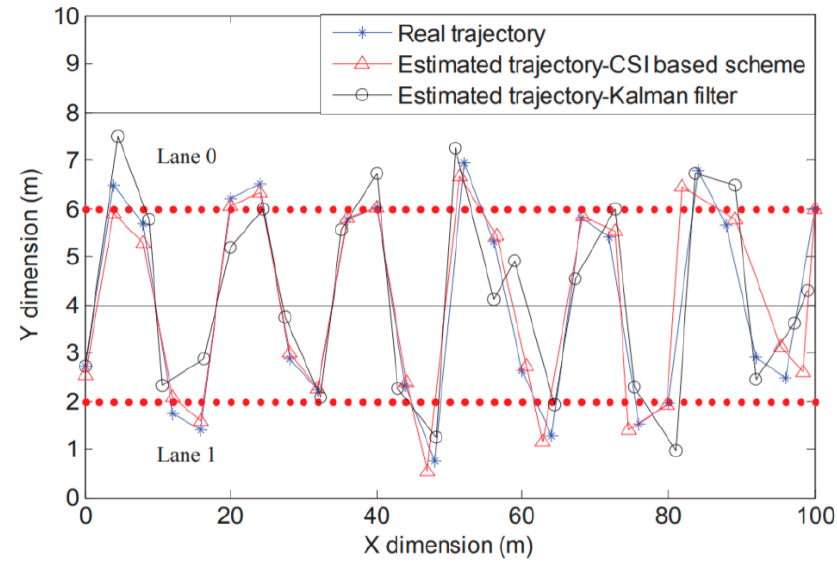
Figure 11. Estimated trajectory graph comparison.